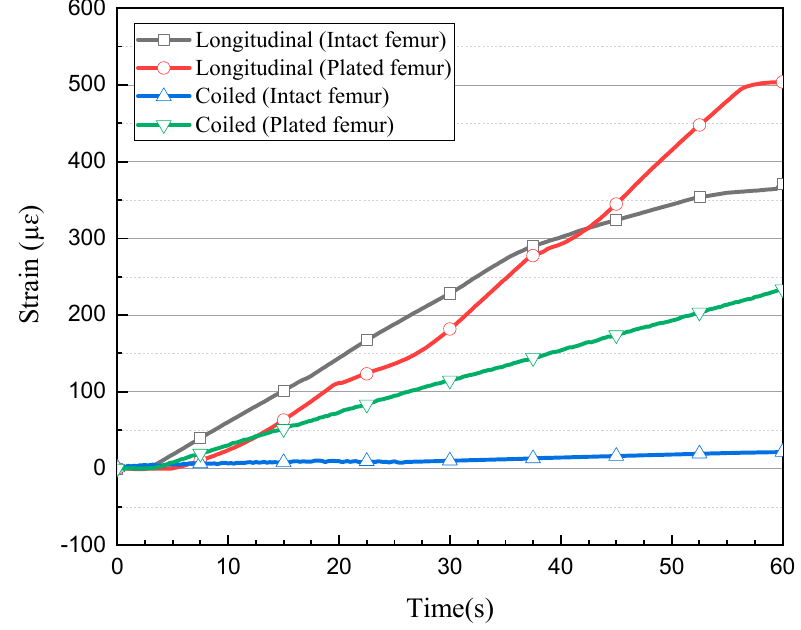
Figure 6. Comparison of strain level measured by the central FBG sensor during each test.